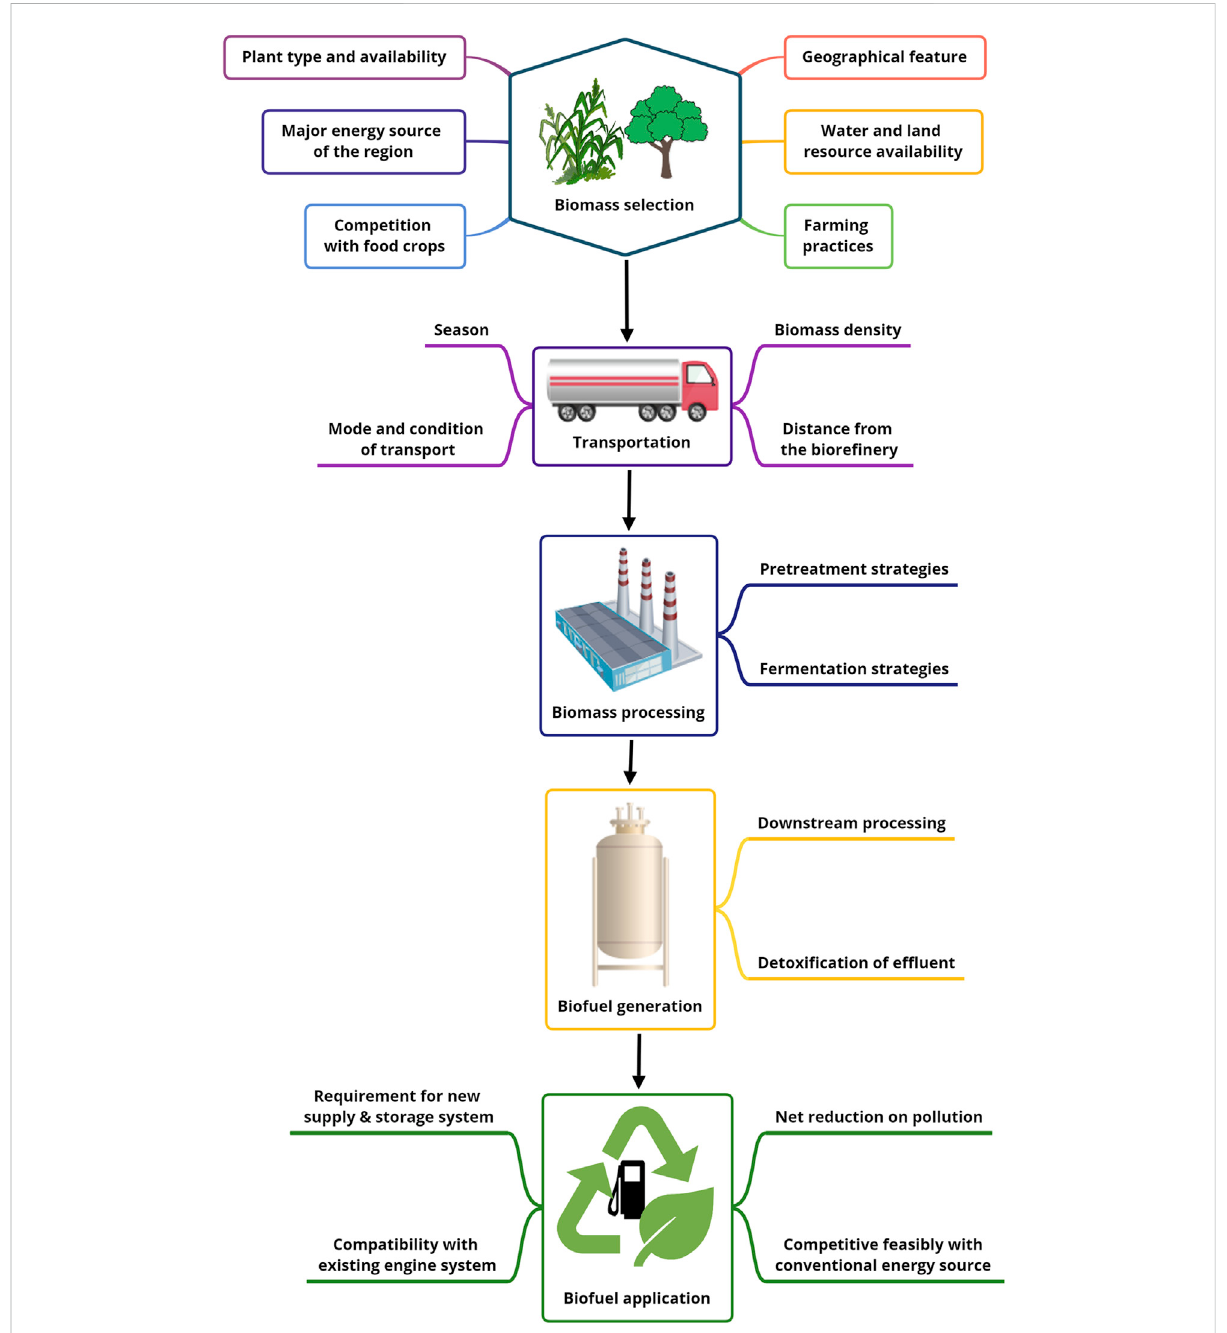
FIGURE 1 Schematic representation of the various points of Life cycle analysis for biofuel production from